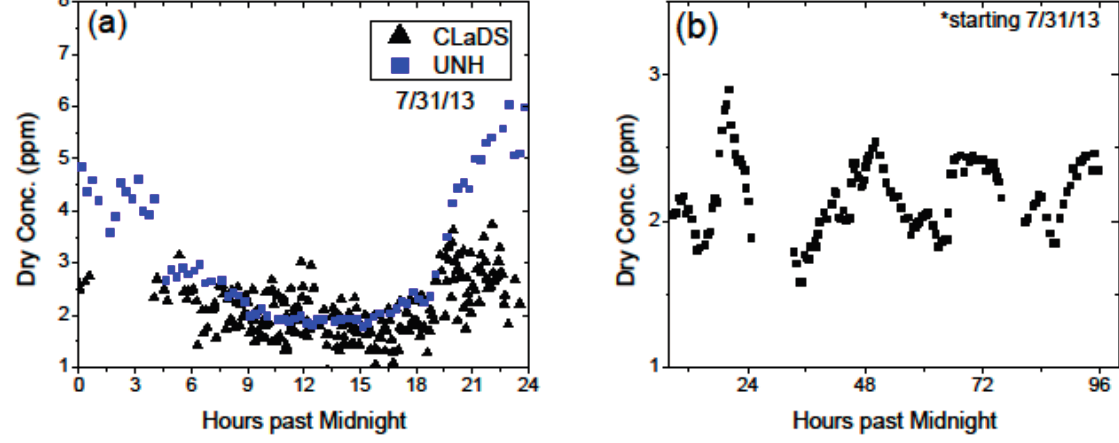
Figure 7. ( a ) Observed diurnal cycle in both the CLaDS system (black) and the University of New Hampshire (UNH) chamber system (blue) on 31 July 2013. Discrepancies in the nighttime peaks are expected due to surface accumulations under the nocturnal boundary layer conditions; ( b ) Diurnal peaks for path #3 of the CLaDS system over 4 consecutive days, starting 31 July